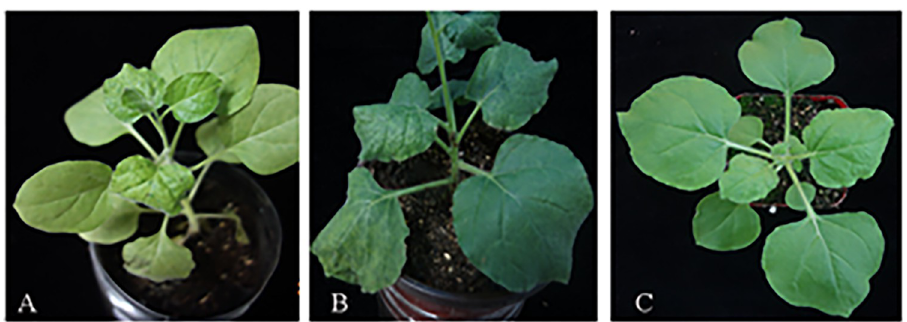
Fig 6. Irrigation test of tobacco. A: Symptoms of tobacco watering with TMV-carrying water after 14 days. B: Symptoms of tobacco watering with TMV-carrying water after 28 days. C: Symptoms of tobacco watering with sterile